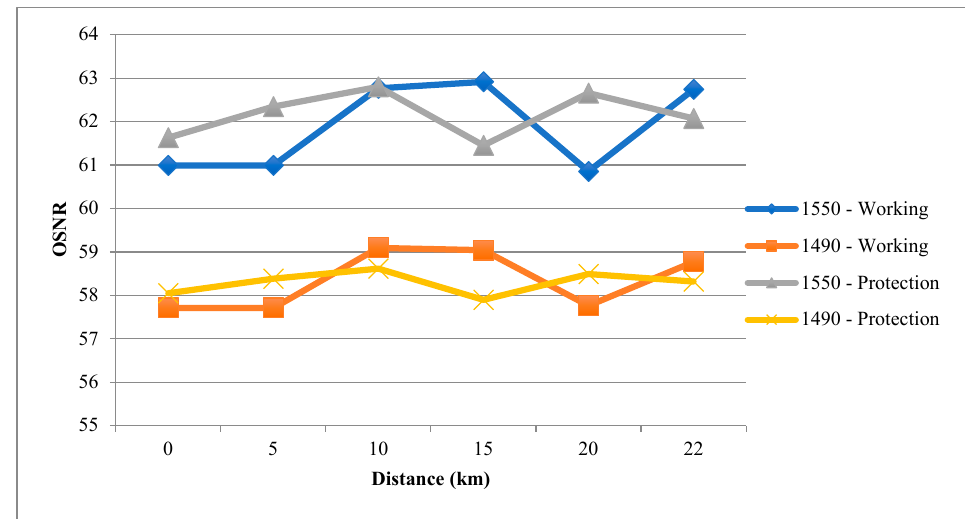
Figure 22. Experimental measurement of OSNR with PROMO in the FTTH system.